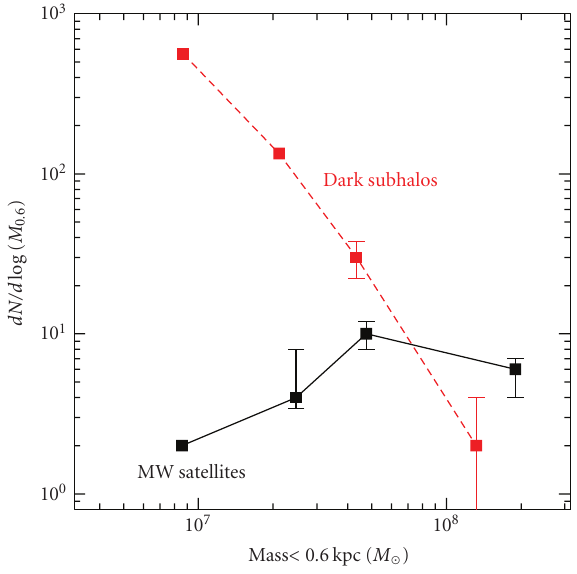
Figure 8: The mass function of dwarf satellites of the Milky Way, where masses of subhalos and observed satellites are measured within a fixed physical radius of 0.6 kpc. Adopted from